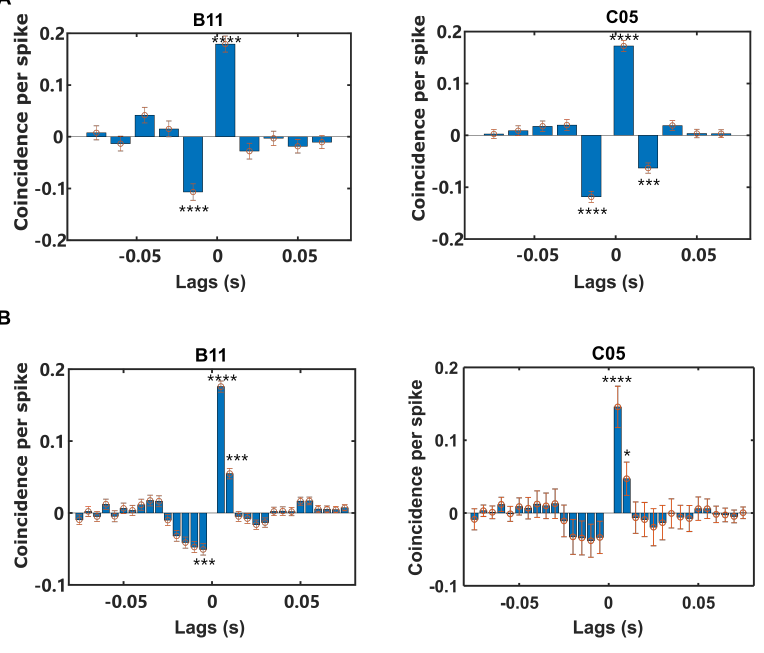
Figure 5. Rewarding neural patterns of BMI-based tasks were temporally precise. ( A ) CCHs of two subjects Attn AE - part of Figure 5 caption in the last session showed pronounced coincidence between two units in a time window spanning from 0 to +15 ms. Error bars denote the SD rendered from the resampling analysis on jittering. The asterisks above the bars indicate a significant coincidence. **** p <0.0001. ( B ) The CCHs of two subjects in the last session with higher resolution showed finer temporal granularity. Error bars denote the SD rendered from the resampling analysis on jittering. The asterisks above the bars indicate a significant coincidence. * p < 0.05, *** p < 0.001, **** p <